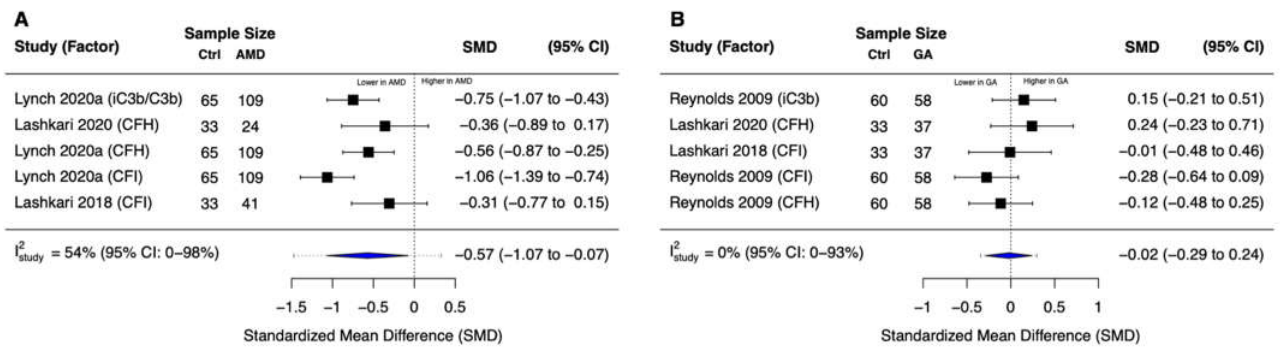
Figure 3. Forest plots for complement inhibition. ( A ) We observed statistically significantly lower systemic complement inhibition in patients with early to intermediate nonexudative AMD versus non-AMD controls ( p = 0.03). ( B ) There was no statistically significant difference in systemic complement inhibition in patients with geographic atrophy versus non-AMD controls ( p = 0.82). Blue diamonds denote the 95% confidence interval (CI); dashed tails denote the 95% prediction interval for this multi-level random-effects model.